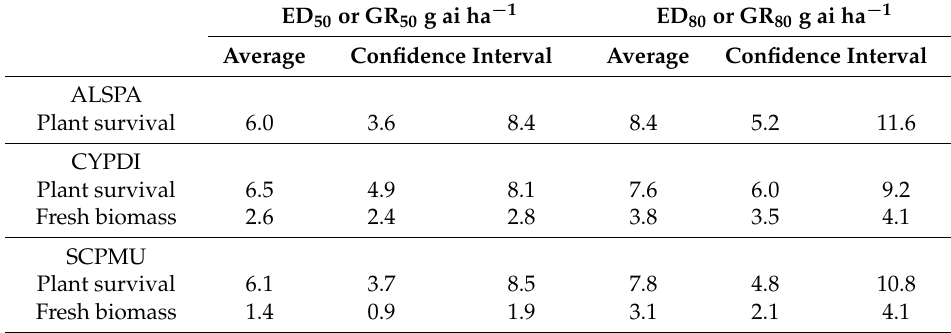
Average values and 95% Confidence Intervals presented here were estimated with a bootstrap procedure and considering only the populations that are still susceptible to ALS